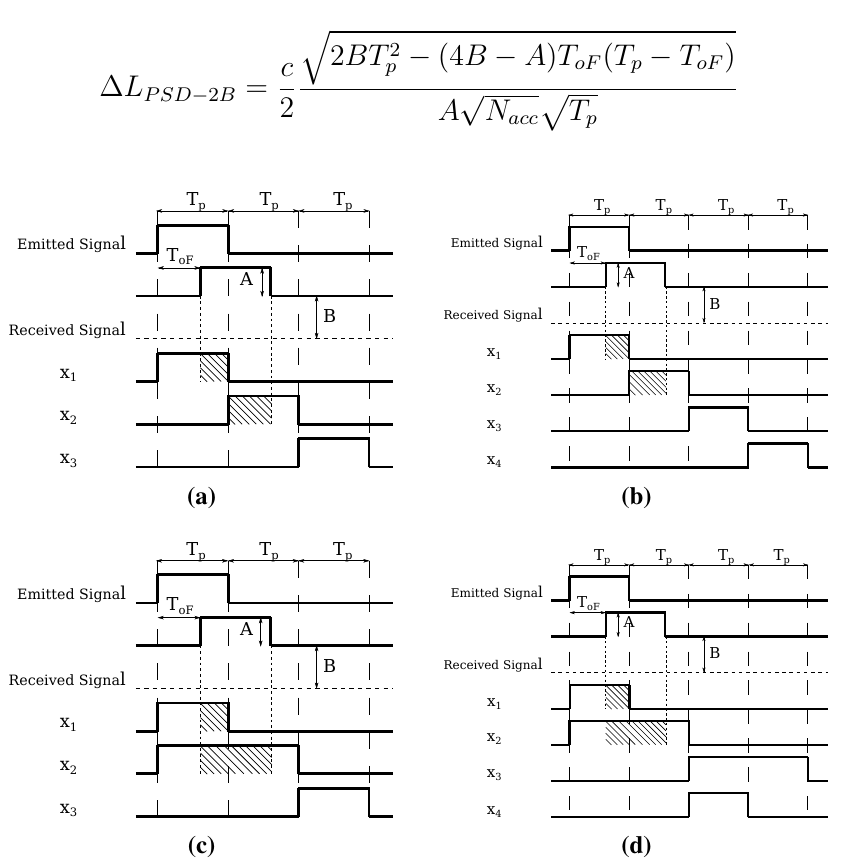
Figure 3. Measurements for pulsed ToF: ( a ) phase shift determination with one background measurement (PSD-1B); ( b ) PSD-2B; ( c ) multiple double short time integration (MDSI)-1B; ( d )